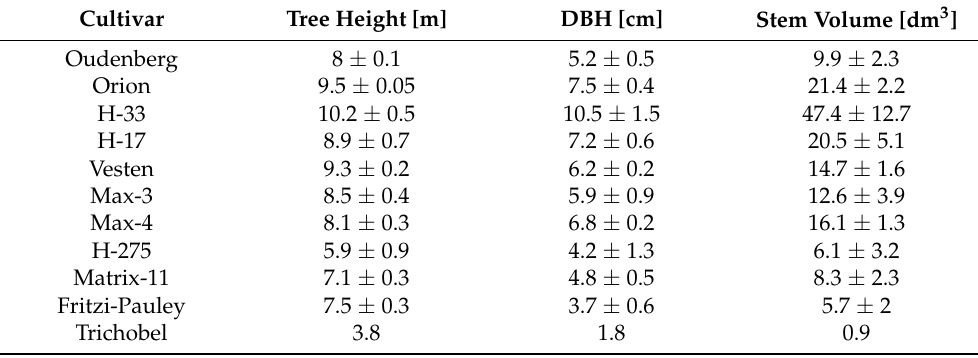
Figure 6. Mean tree heights by parentage groups, expressed by one cultivar per parentage (H-33— PDN, H-275—PMT, Max-4—PNM, and Fritzi-Pauley—PT) from planting time in April 2018 to end of the third season (Oct. 2020) on the site Bishkek I. Table 7. Means ± standard deviations of tree heights [m], and DBH [cm] and stem volumes [dm 3 ] at the end of the growing season 2020 for the site Bishkek I. From all cultivars, except for Trichobel, three trees were measured. Only one Trichobel survived until end of the growing season 2020.